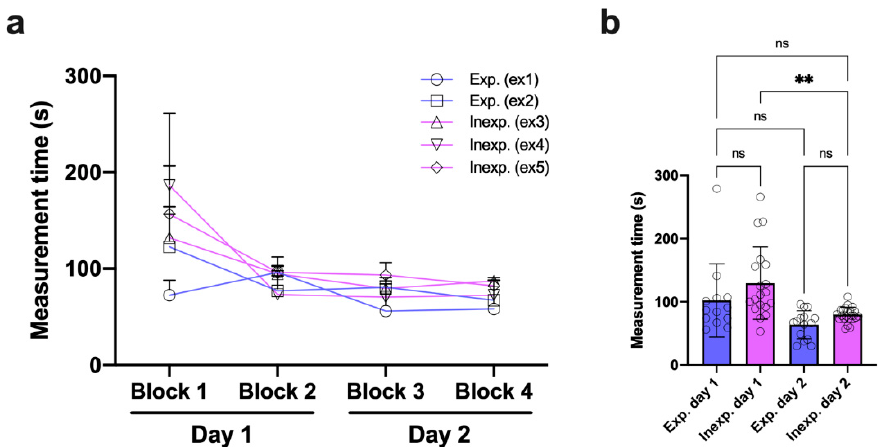
Figure 8. Measurement time analysis. ( a ) Required time separated by examiner and measurement block. ( b ) Required time comparing experienced and inexperienced examiners on experiment days 1 and 2; Kruskal–Wallis test, P < 0.0001; Dunn’s multiple comparisons, ** P = 0.004; Day 1: exp. ( n = 13), inexp. ( n = 19); Day 2: exp. ( n = 15), inexp. ( n = 22). ns,